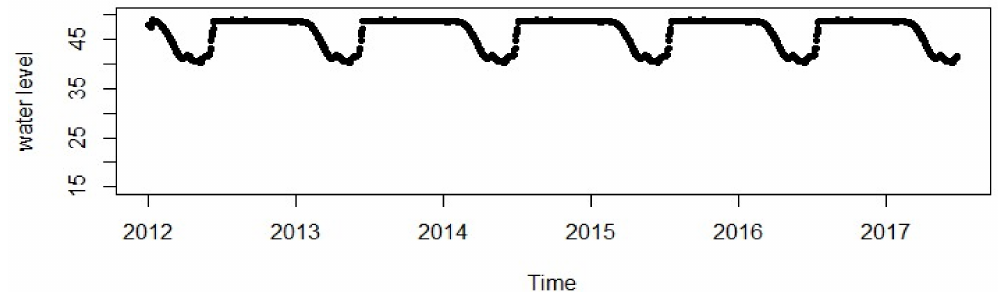
Figure 32. Full dam steady-state, water level in